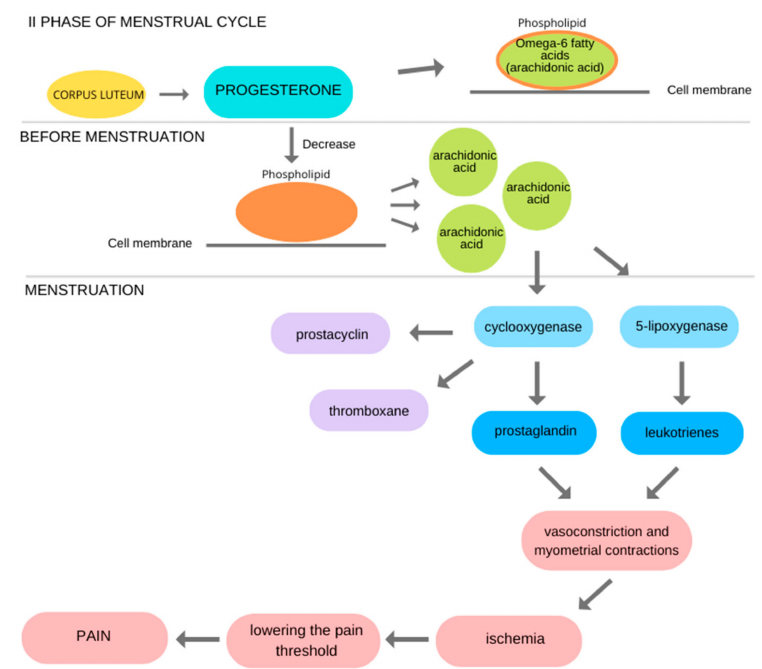
Figure 1. Possible mechanism of menstrual pain. Modified Figure 2 of